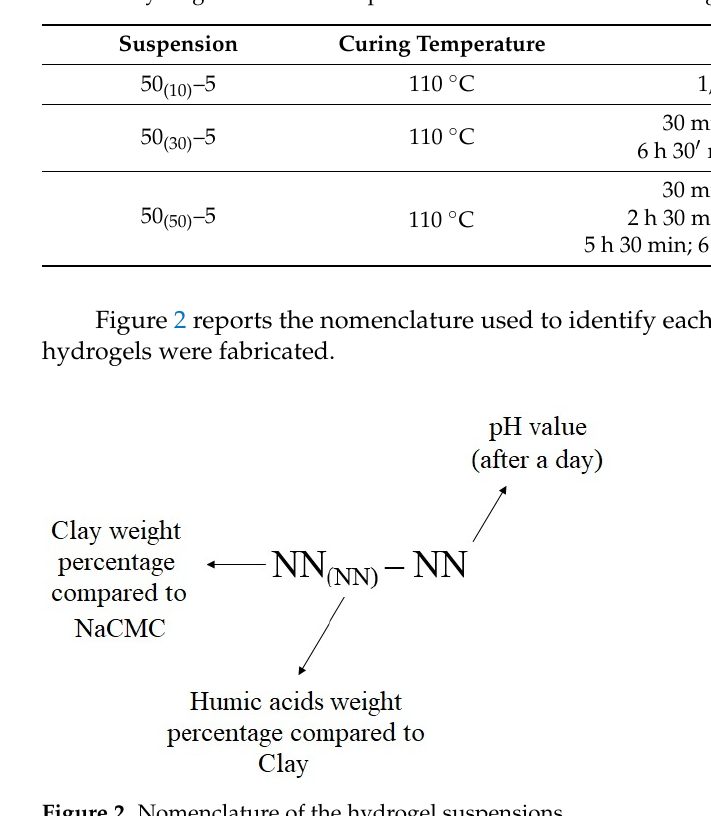
Figure 2. Nomenclature of the hydrogel suspensions.